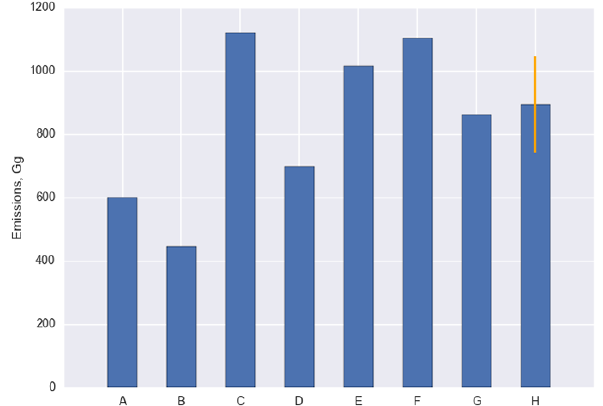
Figure 12. Comparison of current BC emissions estimate with pre- viously published results for India. A: Streets et al. (2003) (base year 2000); B: Reddy and Venkataraman (2002a, 2002b) (base year 1997); C: Sahu et al. (2008) (base year 2011); D: Schultz et al. (2008) (base year 2010); E: Lu et al. (2011) (base year 2010); F: Klimont et al. (2009) (base year 2010); G: Ohara et al. (2007) (base year 2010); H: this study (base year 2011).